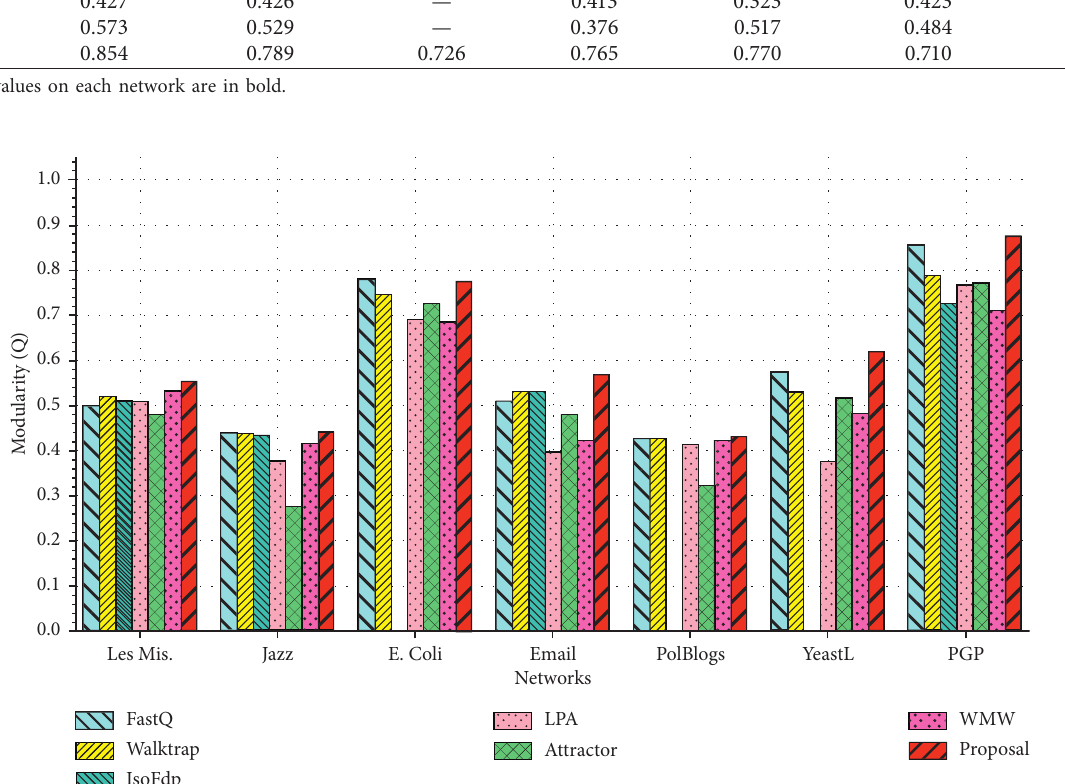
Figure 6: The bar chart of the modularity detected by comparison algorithms and the proposed method from networks without publicly accepted ground-truth community structure.